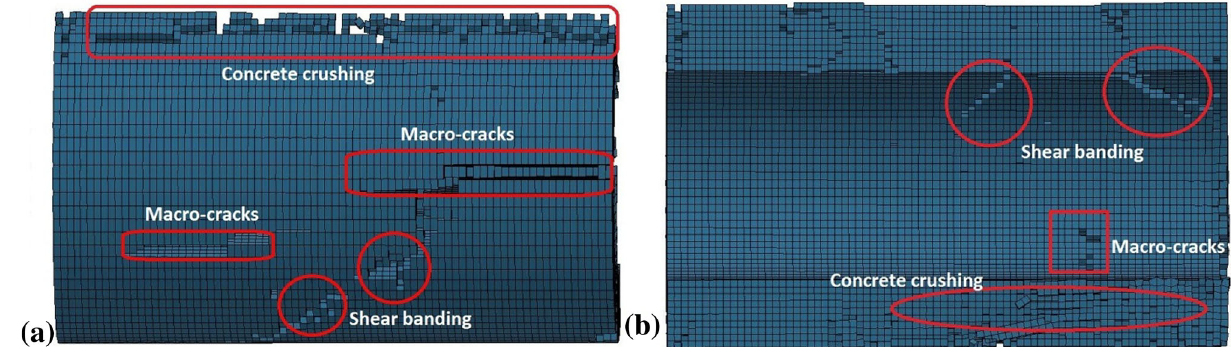
Fig. 21 a Inside of the concrete cask and b outside of the concrete cask.